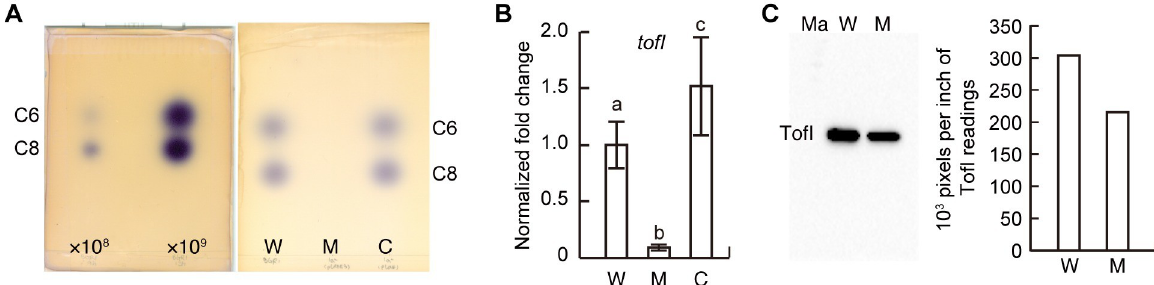
Fig 3. Production of QS signals by the wild type and the complemented strains but not the lon mutant. (A) A significantly larger amount of QS signal was produced by wild-type cells of 1.33 × 10 9 CFU/mL than the wild-type cells of 1.28 × 10 8 CFU/mL. The labels × 10 8 and × 10 9 denote the wild-type cell densities of 1.28 × 10 8 CFU/mL and 1.33 × 10 9 CFU/mL. TLC analysis of acyl-HSLs extracted from the wild type (3.48 × 10 9 CFU/mL), the lon mutant (7.08 × 10 8 CFU/mL), and the complemented strain (3.03 × 10 9 CFU/mL) grown for 24 h in LB supplemented with 100 mM HEPES (pH 7.0). The C6-HSL and C8-HSL were visualized using the acyl-HSL sensor strain CV026. C6, C8, W, M, and C denote C6-HSL, C8-HSL, the wild type, lon mutant, and complemented strain, respectively. (B) Expression of the tofI gene in each strain was determined during mid-log phase by qRT-PCR. W, M, and C denote the wild type, lon mutant, and complemented strains, respectively. The letters (a, b, and c) above each mean indicate significant differences based on a one-way ANOVA, followed by Tukey’s post-hoc analysis. A value of p < 0.05 indicates significant differences among the strains. (C) The amount of TofI-HA in the wild type and lon mutant during early stationary phase was determined via western blot analysis using an anti-HA antibody. The densities (pixels/inch) of the TofI-HA bands are presented alongside the blot. W and M denote the wild type and lon mutant,